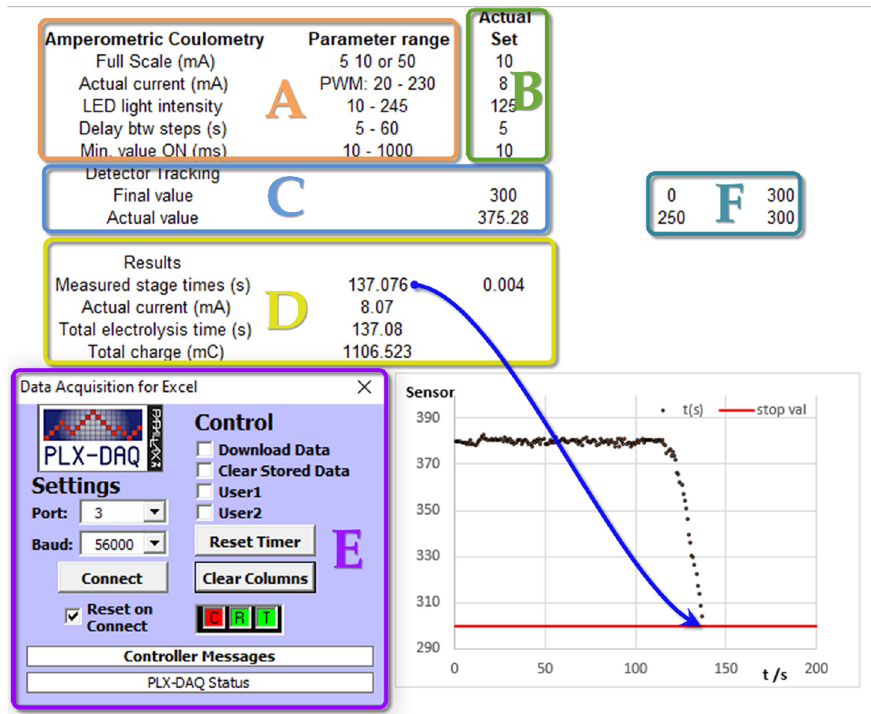
Figure 7. Section of an Excel screenshot for an acid/base coulometric titration using a photodiode OPT101 light sensor. ( A ) Input parameters and verification ranges. ( B ) Actual value set. ( C ) Detector levels set. ( D ) Measurement results. ( E ) Add-on module for serial communication. ( F ) Plot scales.